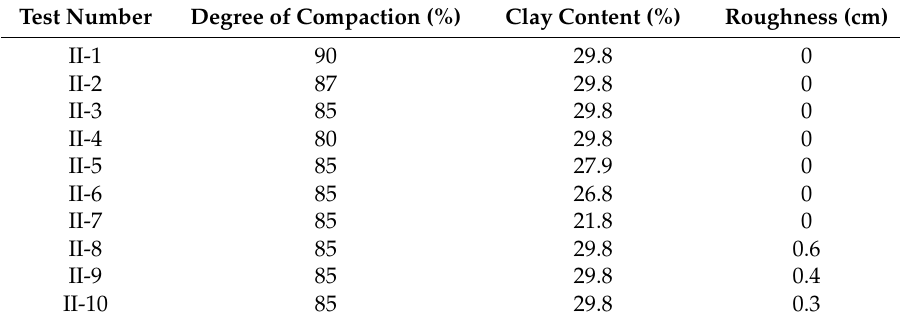
Table 4. Testing scheme of single-factor